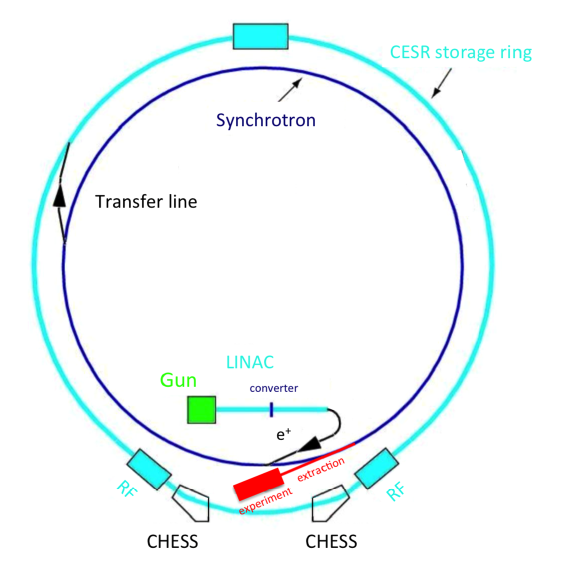
Figure 5. Proposed Cornell extracted beam for dark photon experiments.